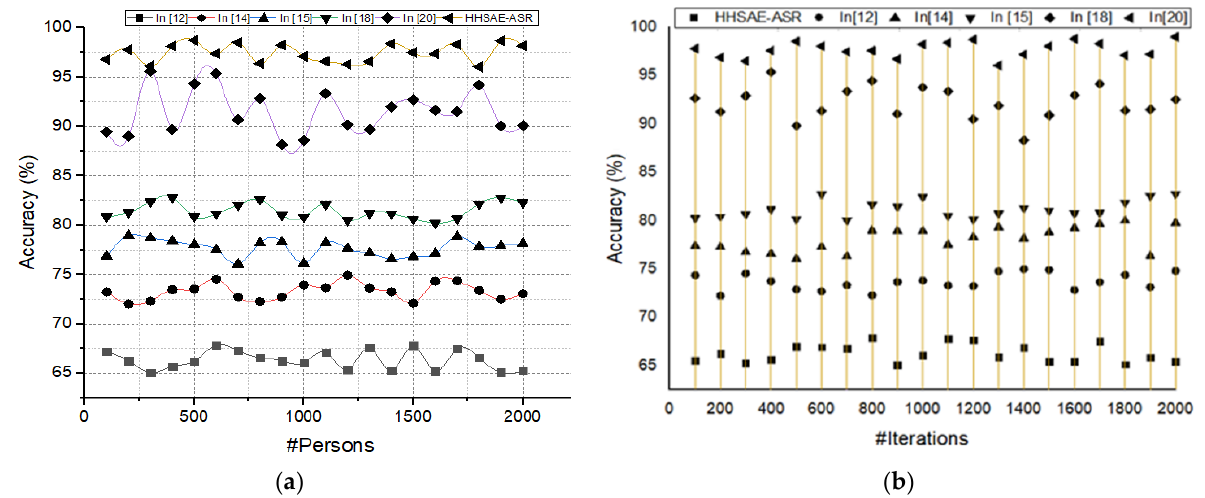
Figure 6. Testing accuracy; ( a ) Test accuracy vs number of persons; ( b ) test accuracy vs the number of iterations. Table 2. Results of subjective